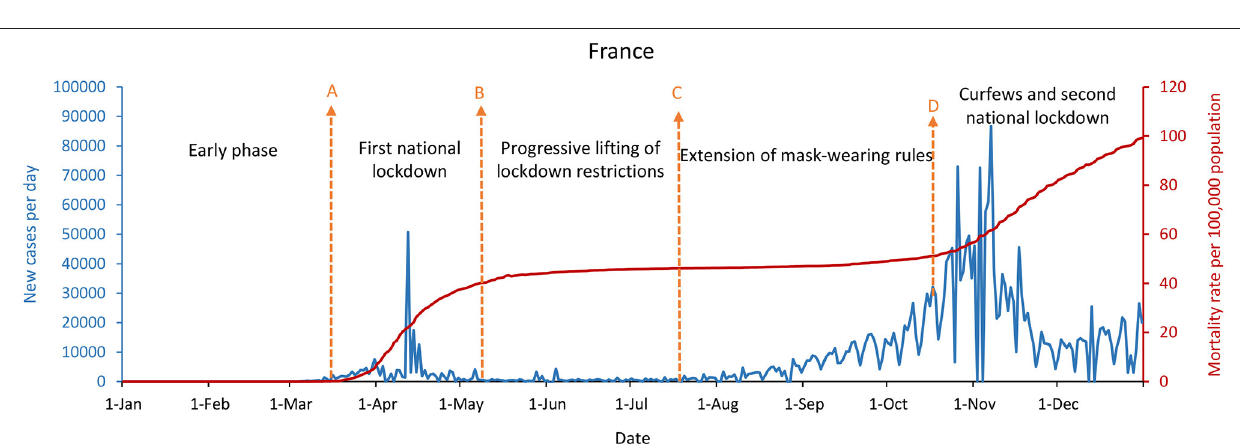
FIGURE 6 | France’s COVID-19 epidemic curves and population mortality rate (between January 1 and December 31, 2020). (A) Beginning of March 17, 2020, first national lockdown. (B) Beginning of May 11, progressive lifting of lockdown restrictions. (C) Beginning of July 20, an extension of mask-wearing rules. (D) Beginning of October 17, curfews and a second national